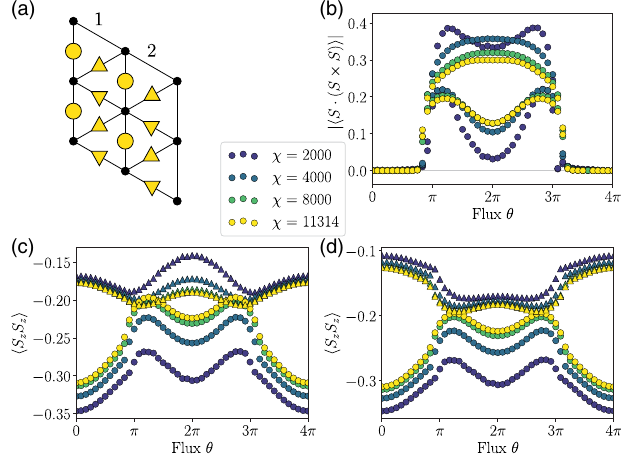
FIG. 10. Flux insertion for YC5 cylinder with U=t ¼ 10 , for a range of bond dimensions. (a) As noted in the text, a two-ring unit cell allows for translation symmetry breaking. Here we label the distinct rings of the cylinder in the unit cell and the three bonds in each ring that may have different h S z S z i correlations. (b) Chiral order parameter on ring 1 (upper curves) and ring 2 (lower curves) of the unit cell. It appears that the lower curve is converged for the largest χ , while the upper one is not, but it does not appear that the two will become equal even in the infinite χ limit. (c) h S S z z i for nearest-neighbor bonds on ring 1 as shown in (a); the symbol for each data point indicates that it corresponds to the bond labeled by that symbol in (a). We do not show the strength of the down-triangle bond because for each χ and θ it is equal to that of the up-triangle bond to better than one part in 10 8 . In the 2D model, all three bonds are equivalent; on the YC cylinder, the vertical bonds are inequivalent to the two diagonal ones. (d) h S z S z i for ring